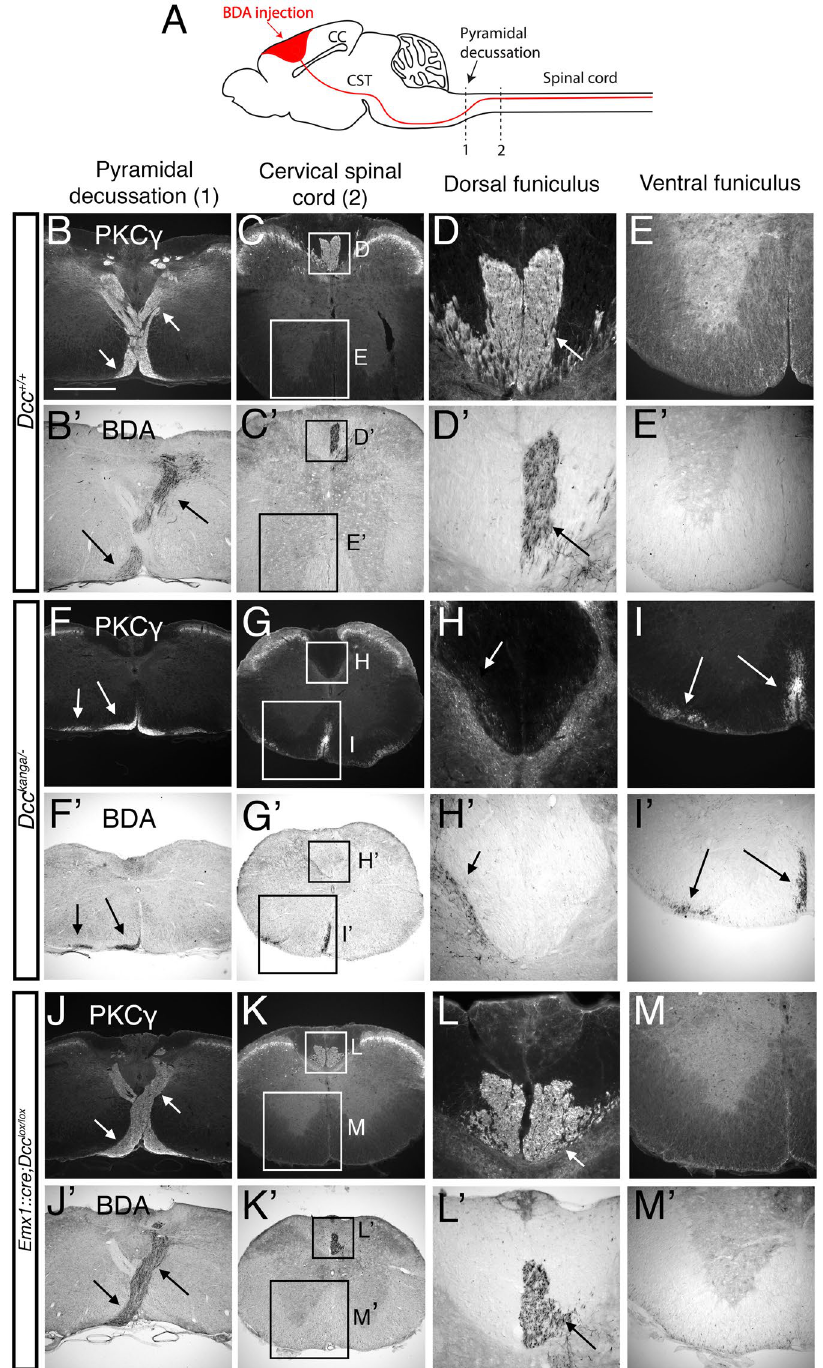
Figure 7. Abrogation of neocortical DCC expression fails to reproduce the abnormal pyramidal decussation observed in Dcc kanga / − mice. ( A ) Schematic representation of a sagittal section through an adult mouse CNS indicating the trajectory of the CST and the level of the coronal sections presented in this figure. Biotin dextran amine (BDA) was injected into the left motor cortex of Dcc + / + (n = 4; B – E , B’–E’), Dcc kanga / − (n = 4; F–I ; F’ – I’) and Emx1 :: cre ; Dcc lox / lox (n = 3; J–M , J’–M’) mice to label the left-sided CST axons. The CST was visualized on coronal sections at the level of the pyramidal decussation and in the spinal cord, by immunostaining against the PKC γ (visualization of the two CSTs; B – M), or by revelation of the BDA tracer (visualization of the left- hand CST alone; B’ – M’). The CST trajectory was similar in Dcc + / + ( B–E ) and Emx1 :: cre ; Dcc lox / lox ( J–M ) mice. In Dcc kanga / − mice, the CST axons did not cross the midline at the pyramidal decussation, but spread in two bundles, one lateral and the other medial, that remained in the ventral ipsilateral spinal cord ( F–I ). The scale bar represents 336 μ m in B, C, F, G, J, K; 168 μ m in E, I, M; and 84 μ m in D, H,